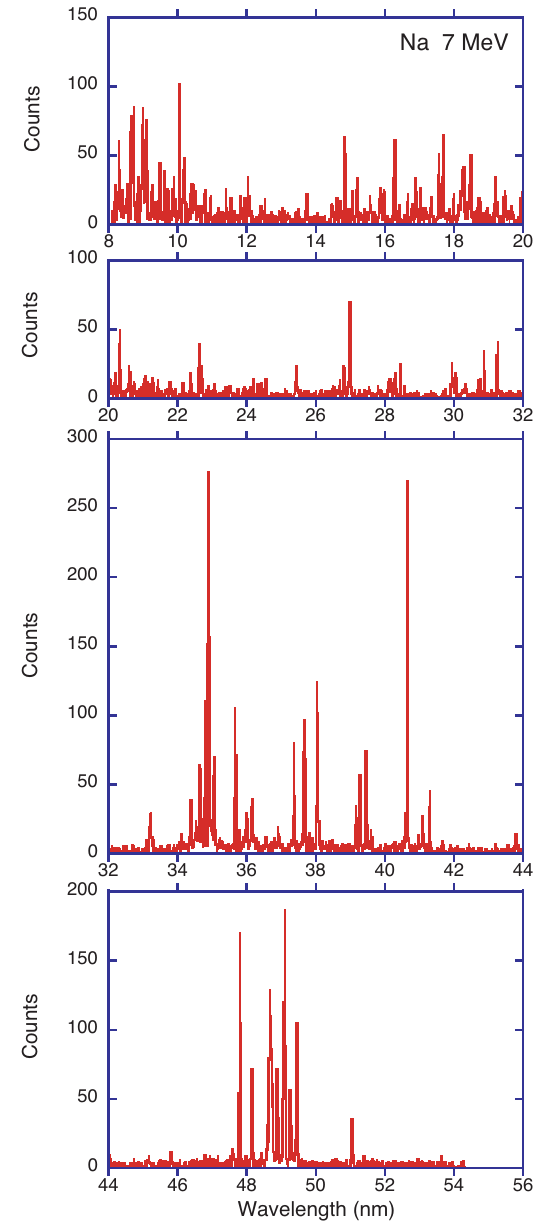
Figure 2. Beam-foil spectrum of Na at an ion beam energy of 7 MeV (unpublished data collected for